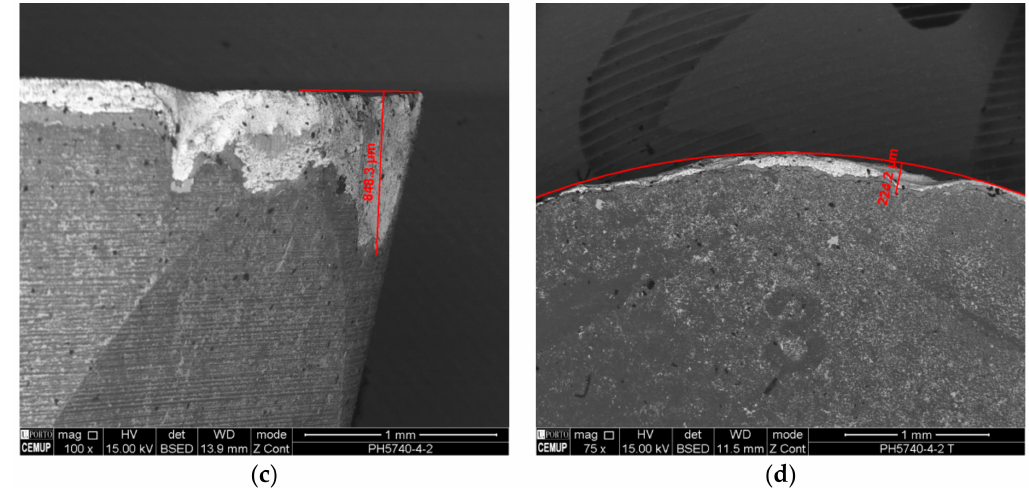
Figure 12. ( a ) and ( c ) flank wear (VB) of CVD PH5740-L1 and PH5740-L2 cutting inserts, respectively;